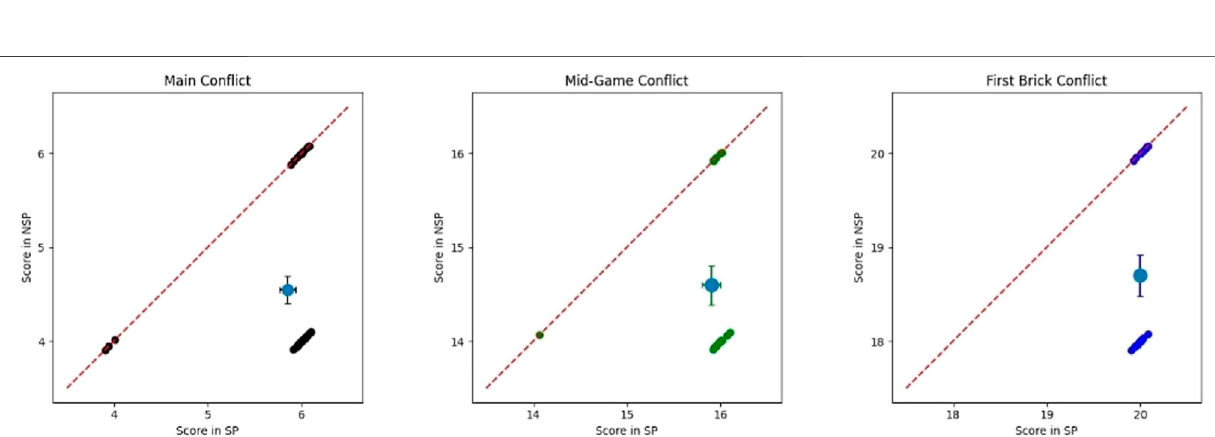
FIGURE 3 | Average and standard error of the Main Con fl ict ’ s covered brick taking percentage. In this case, the covered bricks were the E and G ones.